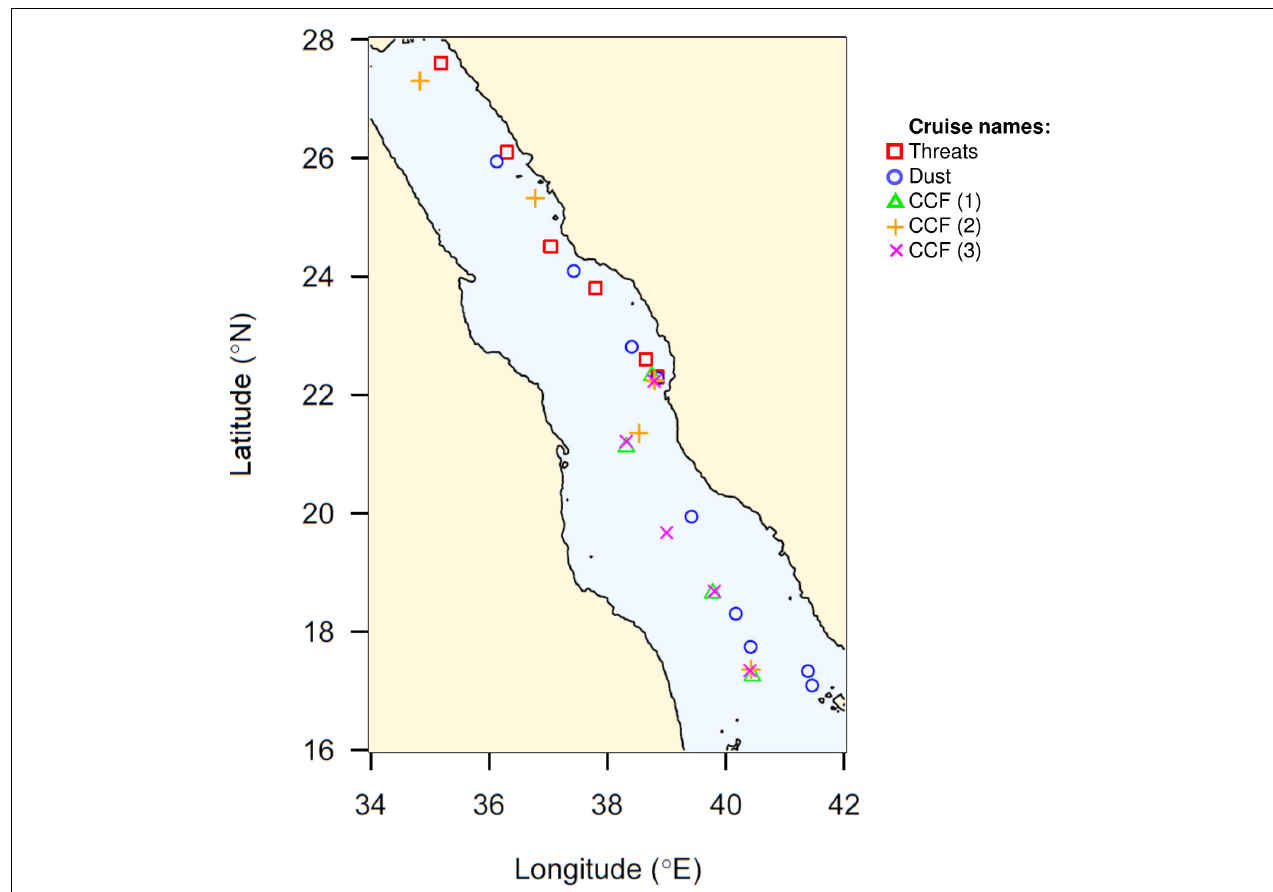
FIGURE 1 | Map showing the distribution of the sampling sites along the Red Sea basin. The different cruises are indicated by their correspondent